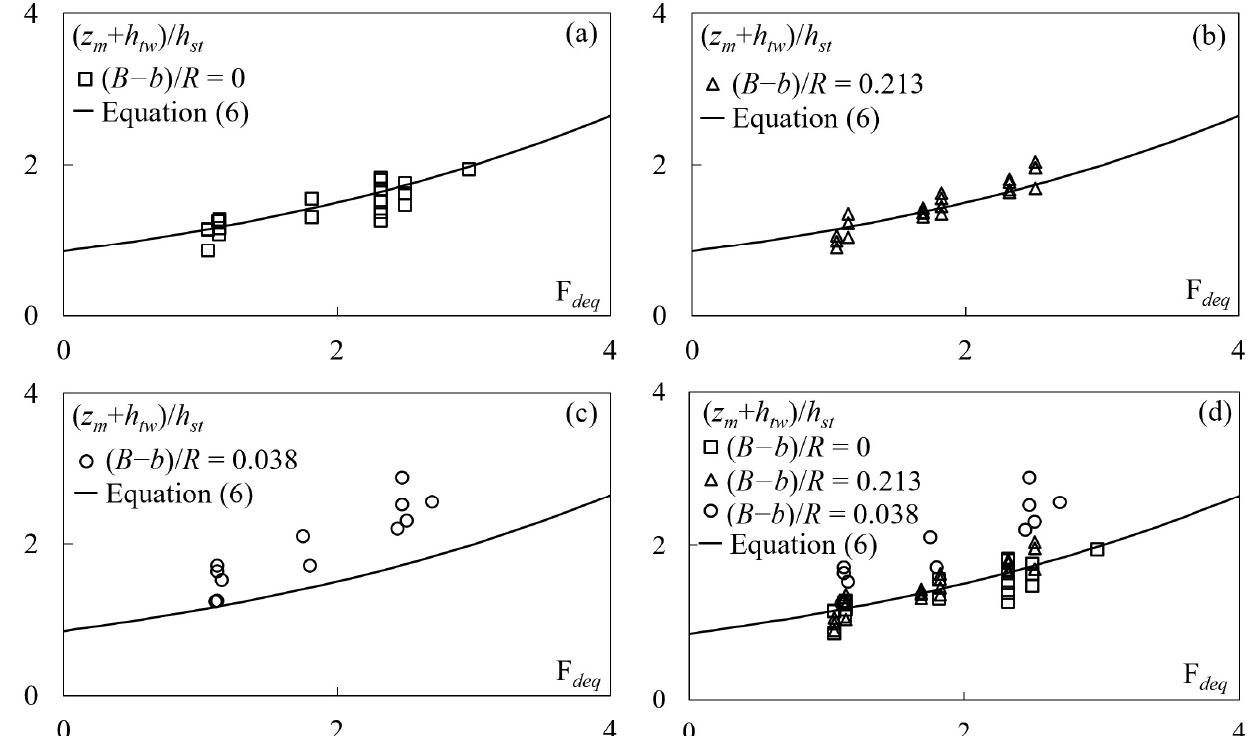
Figure 4. ( z m + h tw )/ h st vs. F deq for wood bundles inserted in ( a ) a straight channel, i.e., ( B − b )/ R = 0; ( b ) the inner bank of a curved channel, i.e., ( B − b )/ R = 0.213; ( c ) the outer bank of a curved channel, i.e., ( B − b )/ R = 0.038. Figure ( d ) summarizes all the channel types.